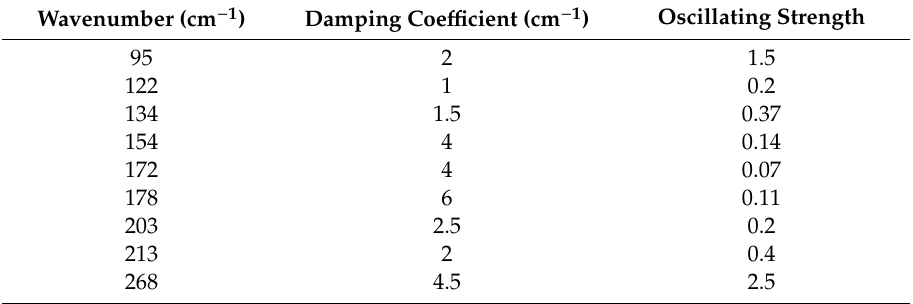
Table 1. Parameters of A 1 modes under 300 cm − 1 of KTiOPO 4